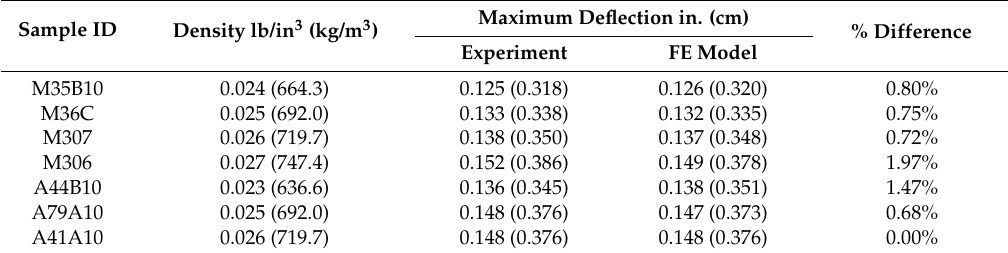
Table 4. Charpy Impact model maple and ash wood deflection correlation results.